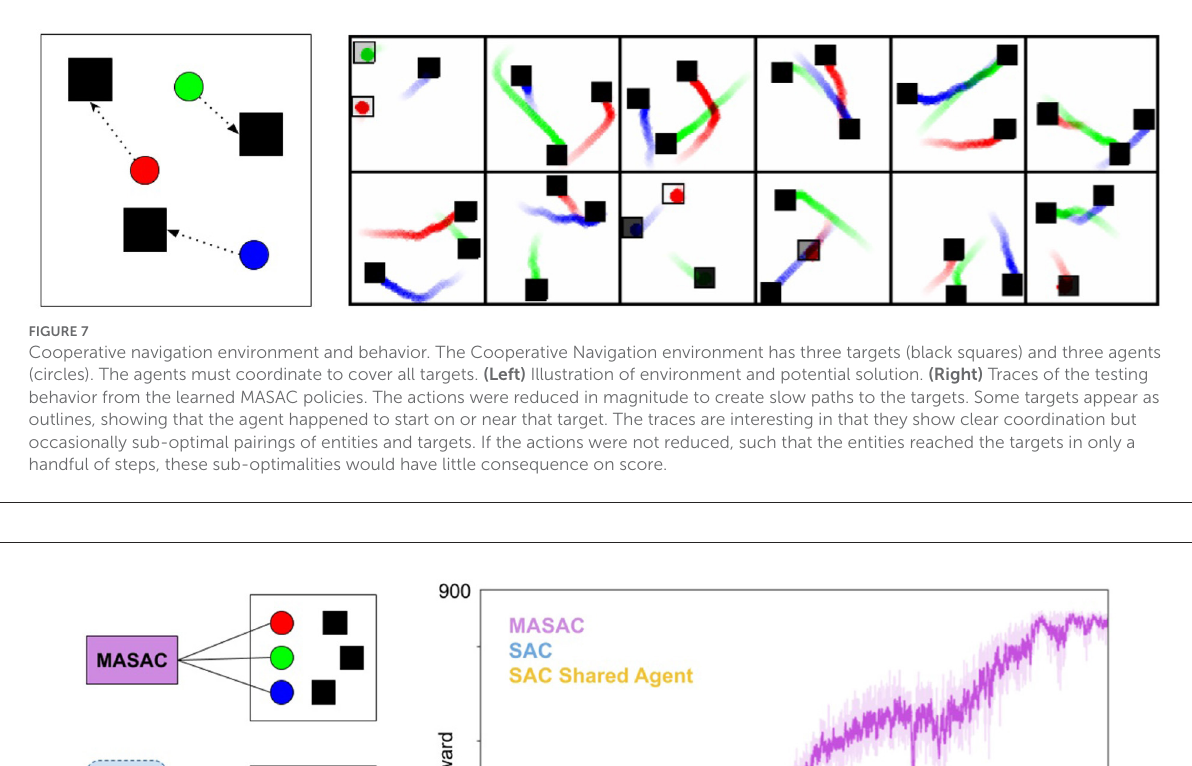
(SAC) (Haarnoja et al., 2018) on the emergence of